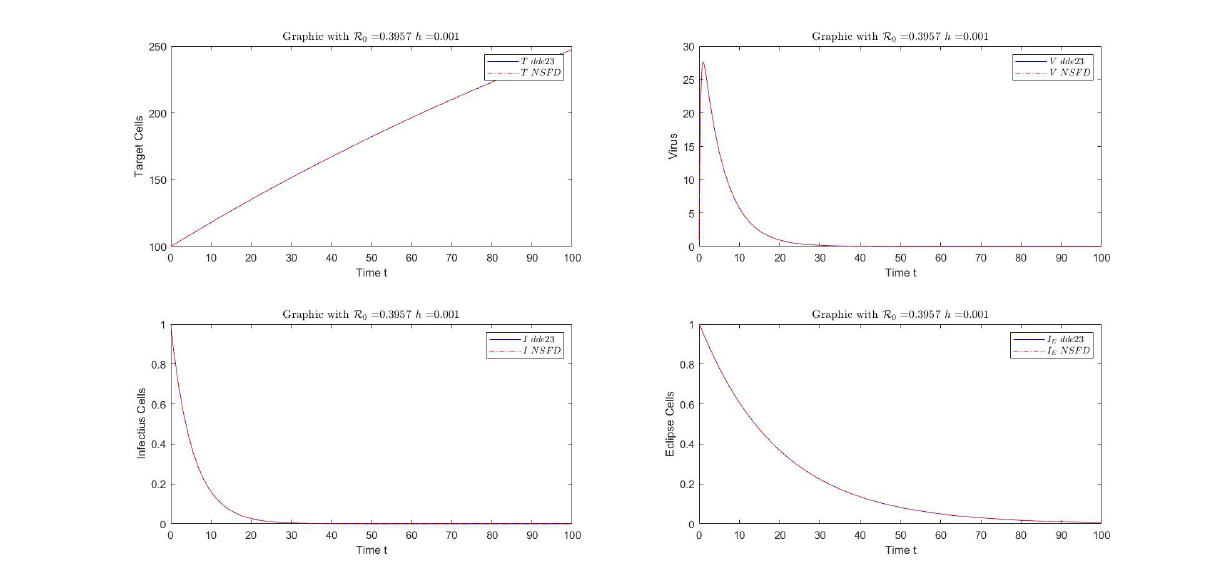
Figure 2. Simulation NSFD versus dde23 when R 0 <